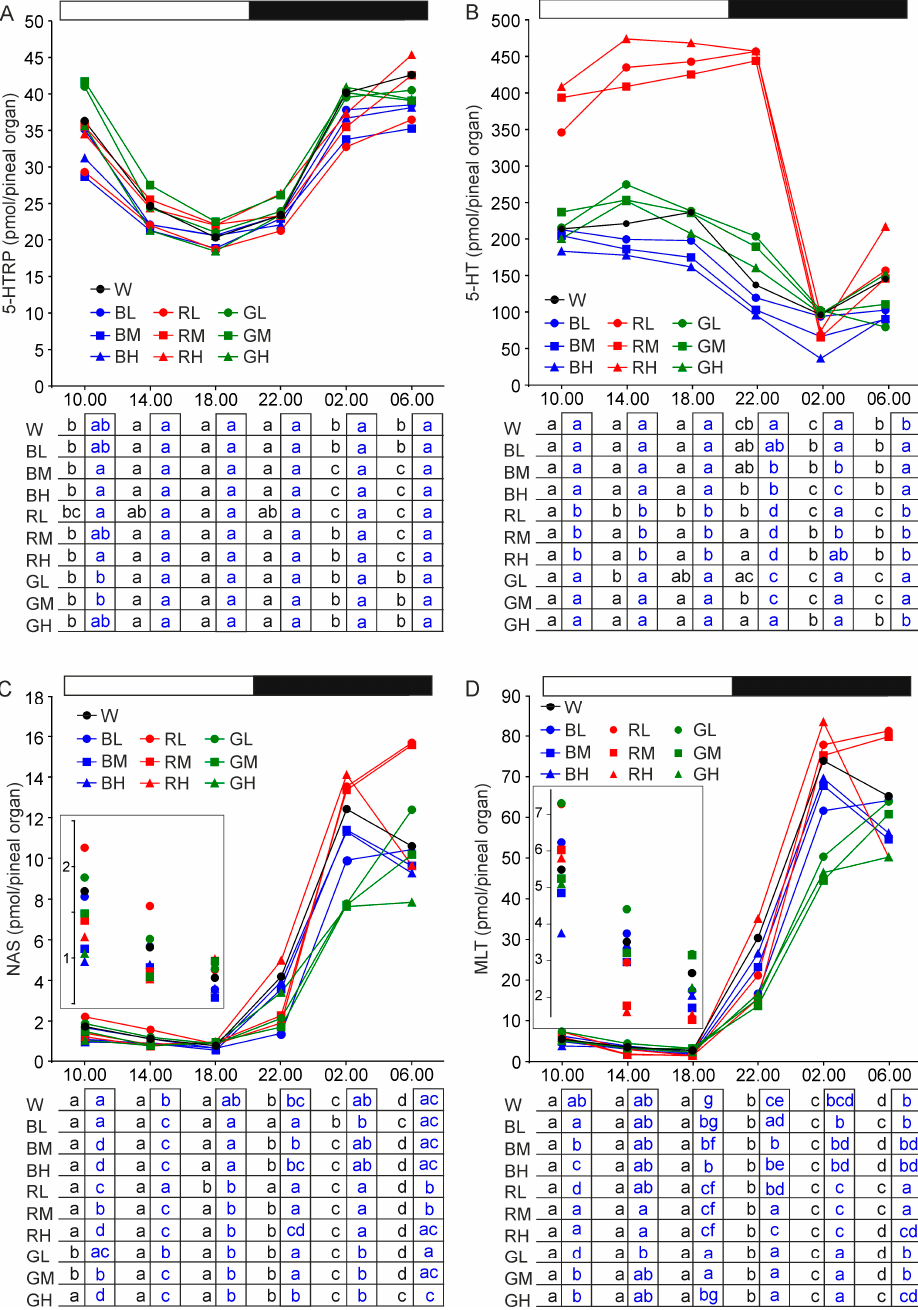
Figure 3. Content (means) of 5-hydroxytryptophan, 5-HTRP ( A ), serotonin, 5-HT ( B ), N-acetylserotonin, NAS ( C ), and melatonin, MLT ( D ) in the pineal organs of turkeys kept under white light (W) with intensity of 16 lx, blue light with intensities of 16 lx (BL), 32 lx (BM), and 64 lx (BH), red light with intensities of 16 lx (RL), 32 lx (RM), and 64 lx (RH), green light with intensities of 16 lx (GL), 32 lx (GM), and 64 lx (GH) during the photophase. For further explanation, see Figure 1.